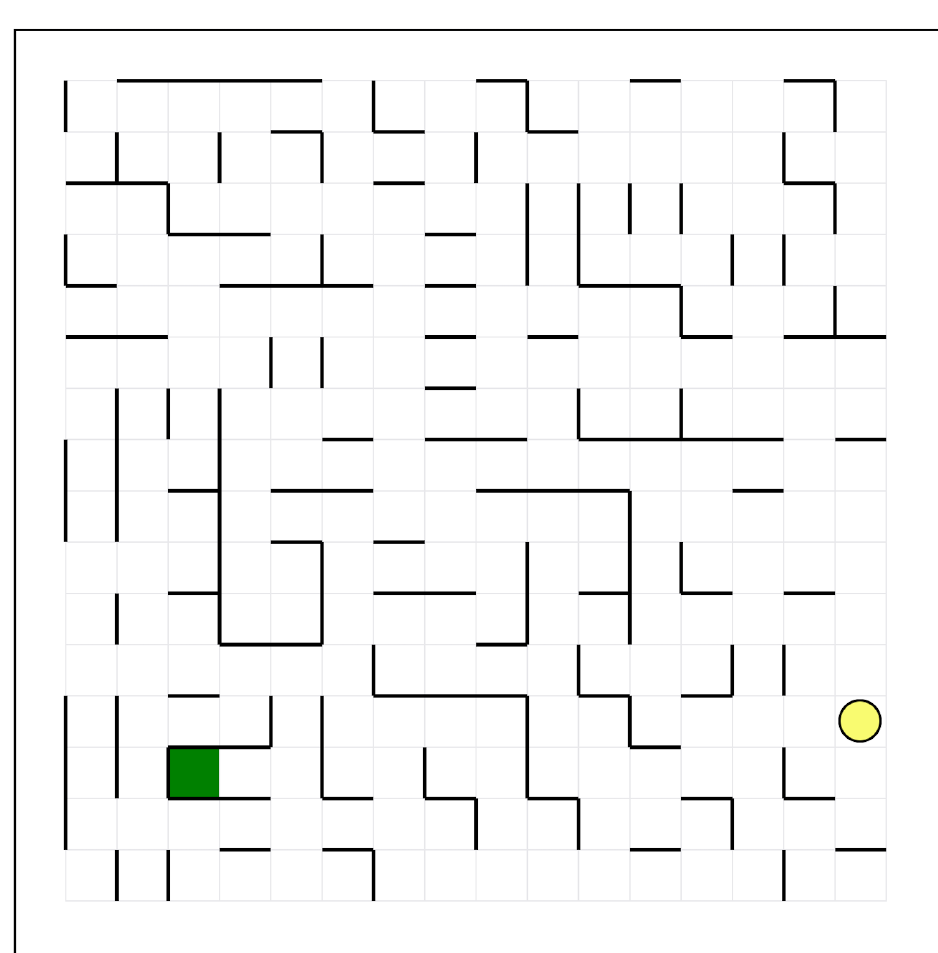
Figure 2. GridWorld